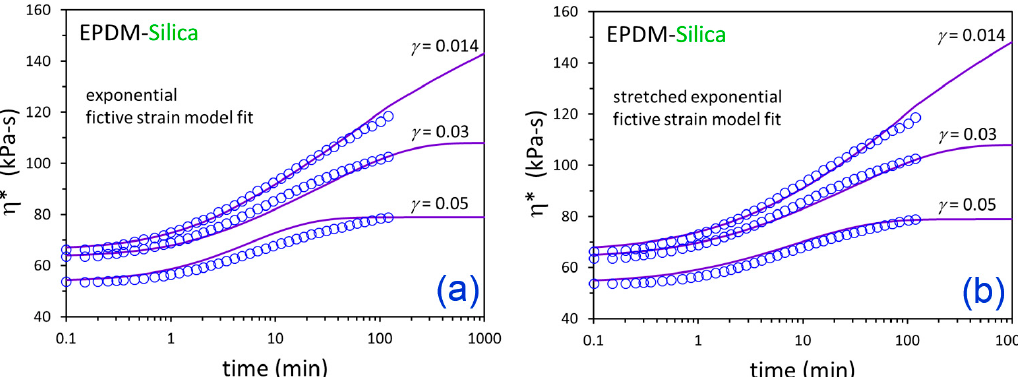
Figure 8. Time-dependent η * data (symbols) after down-jump from equilibrium at γ = 0.25 to the indicated γ values and fictive strain model fits (solid lines) for EPDM-Silica using the exponential ( a ) and stretched exponential ( b ) versions of the model. Table 3. Fictive strain model